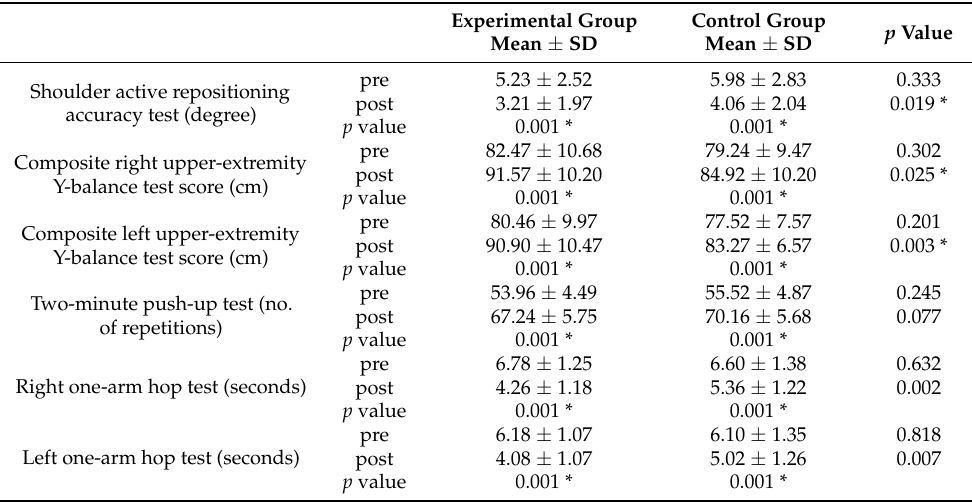
Table 2. The pre and post values of the Biodex balance and composite upper-quarter Y-balance test scores of both